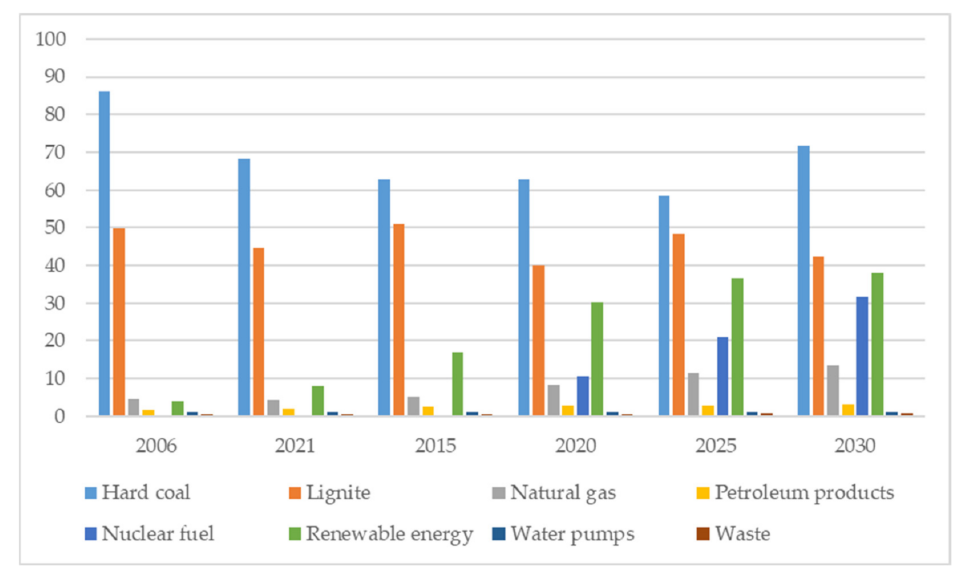
Figure 4. Net power generation by fuel in 2021–2030 [TWh]. Source: developed by the authors, based on Reference